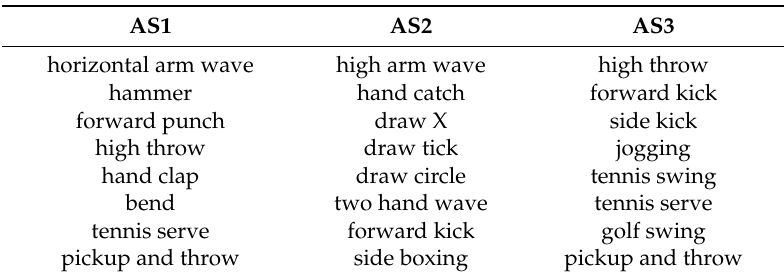
Table 1. Actions in actions subset AS1, AS2 and